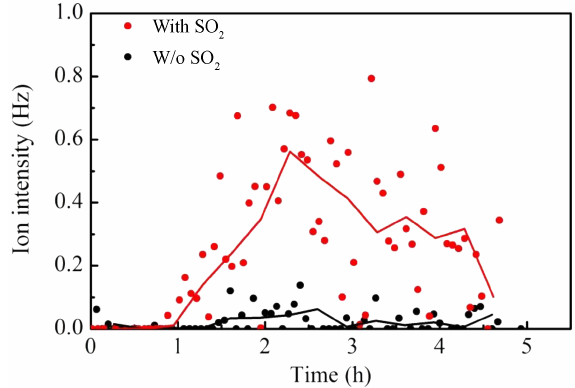
Figure 9. Time evolution of m/z 88 during the aging of LDGV exhaust from vehicle III. Solid lines are derived from the average values of every five data points.